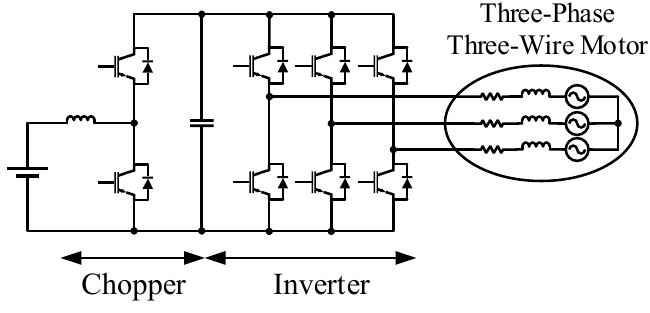
Figure 1. Circuit configuration of conventional single inverter motor drive.